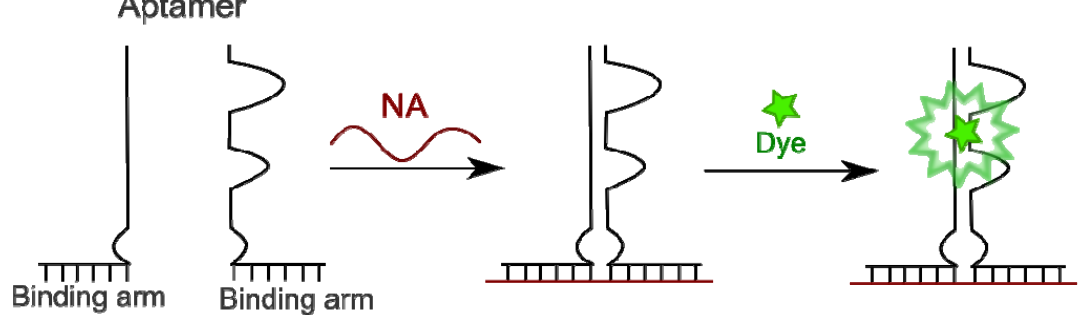
Figure 18. Fluorophore-binding aptamers as binary